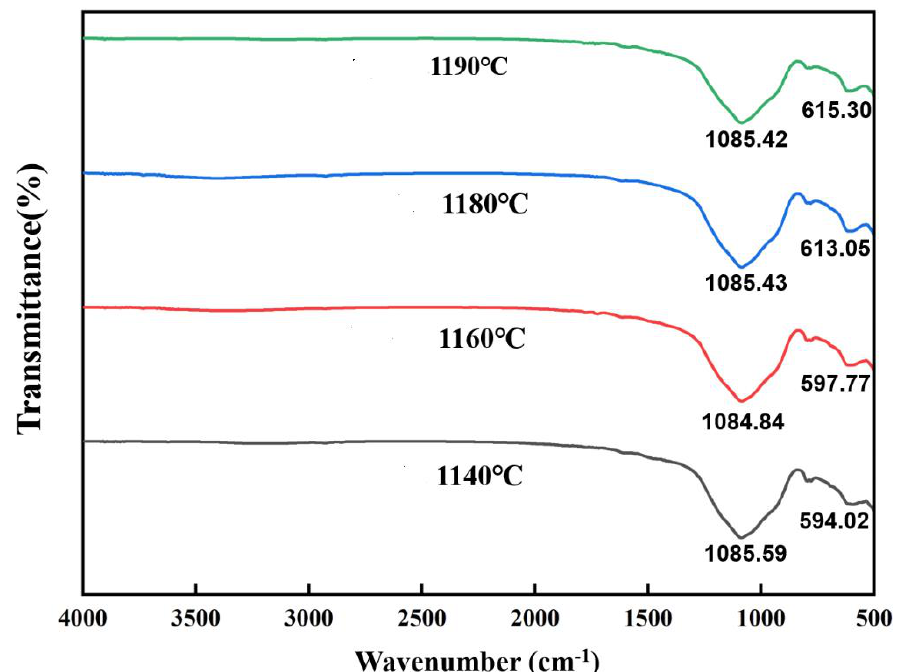
Figure 7. Infrared spectrum of ceramsite sintered at various temperatures.